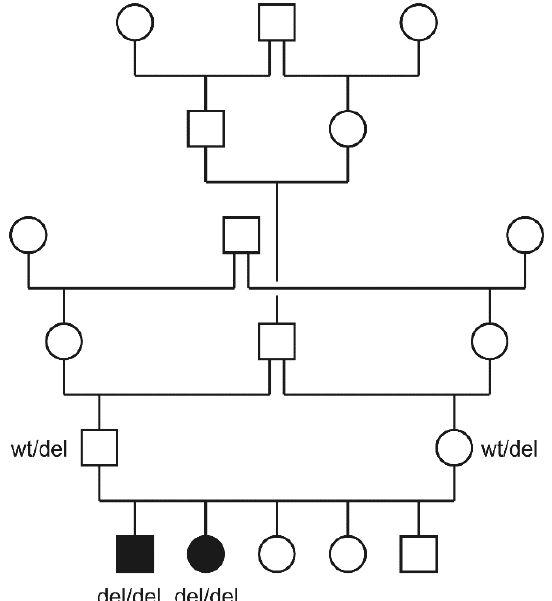
Figure 3. Pedigree of the investigated British Shorthair family. Filled symbols indicate affected cats and open symbols indicate non-affected cats. Squares and circles represent males and females, respectively. Note the multiple inbreeding loops in this pedigree. Genotypes at the LTBP3 :c.158del variant are given for cats from which the samples were available.